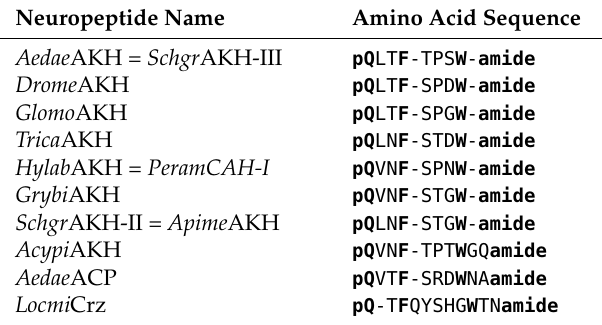
Table 1. Primary structure of the peptides used in the current study. The conserved residues are shown in bold, while dashes were introduced to align the sequences. Abbreviations used: AKH, adipokinetic hormone; Crz, corazonin; ACP, AKH/Crz-related peptide. Neuropeptide Name Amino Acid Sequence